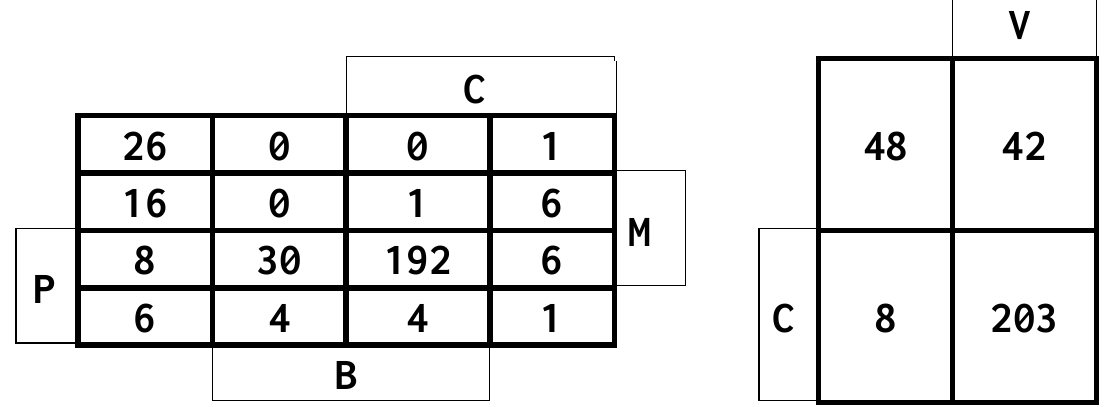
Fig. 6. Map construction of the contingency table of 𝐶 with respect to 𝑉 , where 𝑉 is the voting function (the